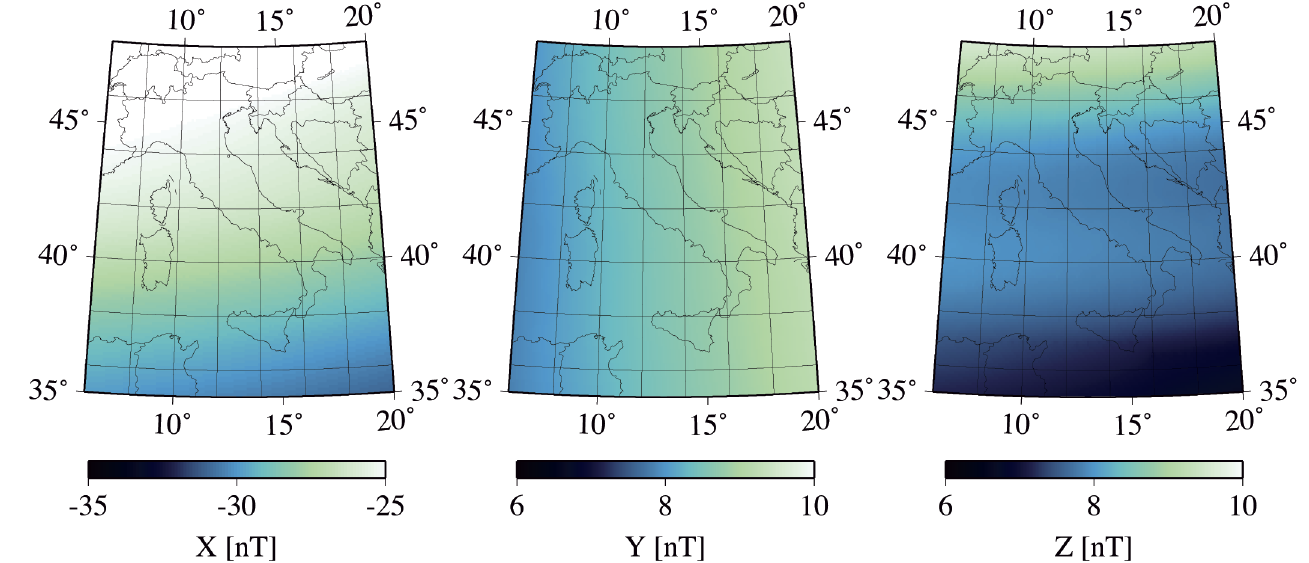
Figure 1. Difference in the total external contribution, i.e. magnetospheric and ionospheric primary and induced, between 2000.0 (maximum solar activity) and 1995.0 (minimum solar activity) estimated by means of CM4 model for X , Y and Z magnetic